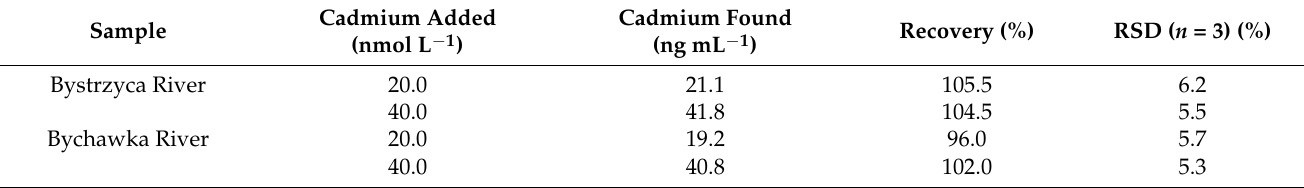
Figure 6. Differential pulse voltammograms obtained during Cd(II) determination in Bystrzyca River water samples: diluted five-fold ( a ); as ( a ) + 4 × 10 −8 mol L −1 Cd(II) ( b ); as ( a ) + 8 × 10 −8 mol L −1 Cd(II) ( c ); as ( a ) + 1.2 × 10 −7 mol L −1 Cd(II) ( d ). Table 3. Analysis of water samples from the Bystrzyca and Bychawka Rivers. The samples were examined using the standard addition method.